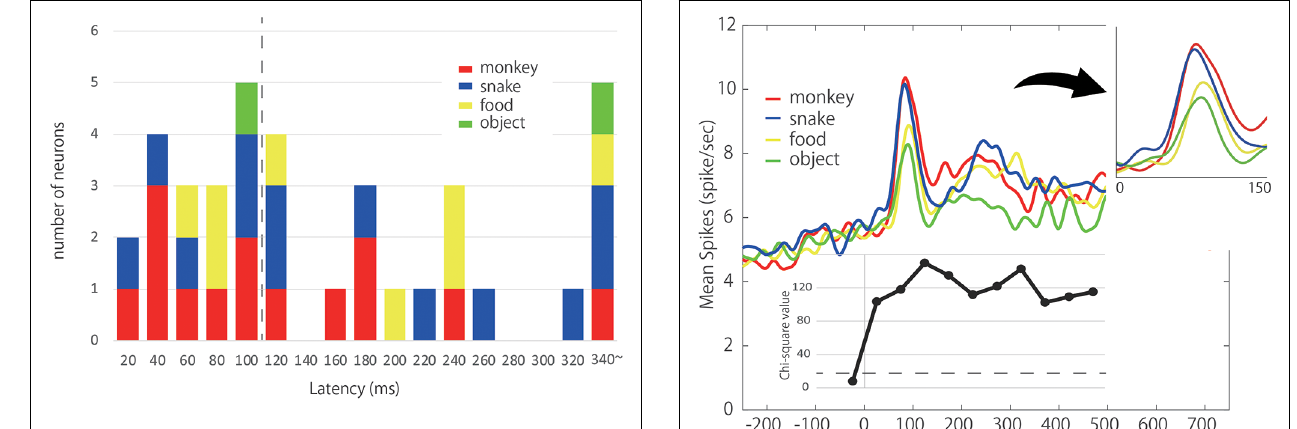
FIGURE 4 | Response latencies and optimal stimuli. The histogram illustrates the distribution of latencies of the ACC neurons responsive to photos. Each color corresponds to a category of the optimal stimulus; red: Monkey Face , blue: Snake , yellow: Food , green: Object. The dashed line indicates the mean value of visual response latencies reported by Pouget et al. (2005). We found 18 responsive neurons with a response latency shorter than 112 ms. We defined these 18 neurons as “quick response” neurons.